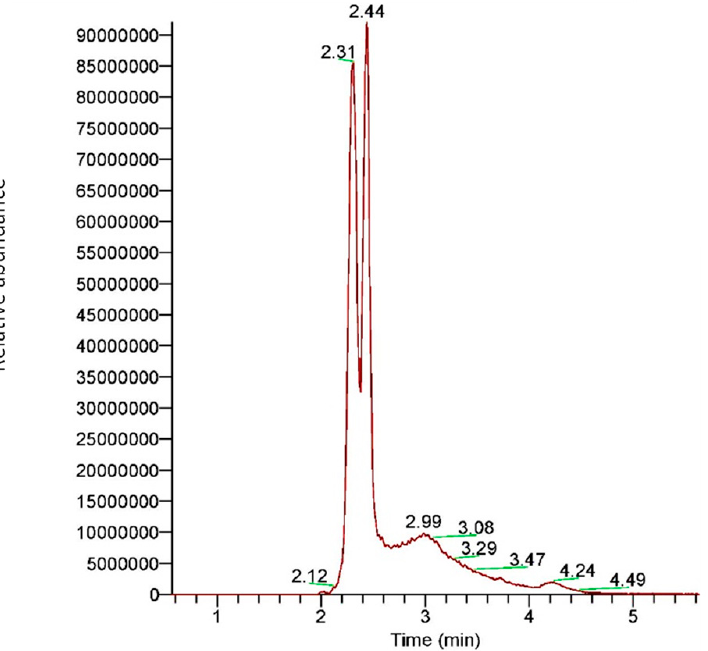
Figure 9. Extracted ion chromatogram for galactooligosaccharides with DP3 (trisaccharides) obtained by β -galactosidase of L. bulgaricus 43. The peak at 2.31 min corresponds to GOS with β -(1 → 3) bond, while the peak at 2.44 min corresponds to GOS with β -(1 → 4) linkage. To establish the potential of the recombinant β -galactosidase to produce GOS, different concentrations of lactose were incubated with 40 U/mL of crude recombinant enzyme, and the enzymatic conversion products were subjected to an HPLC analysis. The ability of the recombinant β -galactosidase for GOS production in vitro is considerable and dose- dependent concerning the substrate (Figure 10). It reached peak values of 70.91 g/L of GOS with DP3 after 12–24 h of incubation with a 200 g/L initial lactose concentration (Figure 10d). This value was not only considerably higher than the values at the same time point for 160 and 120 g/L of lactose (20 and 67%, respectively), but it also remained more stable for the next six hours. Lower concentrations of the substrate increased the speed of the enzyme reaction; at 120 and 80 g/L lactose, the DP3 GOS peak was reached after 12 or even only 6 h,